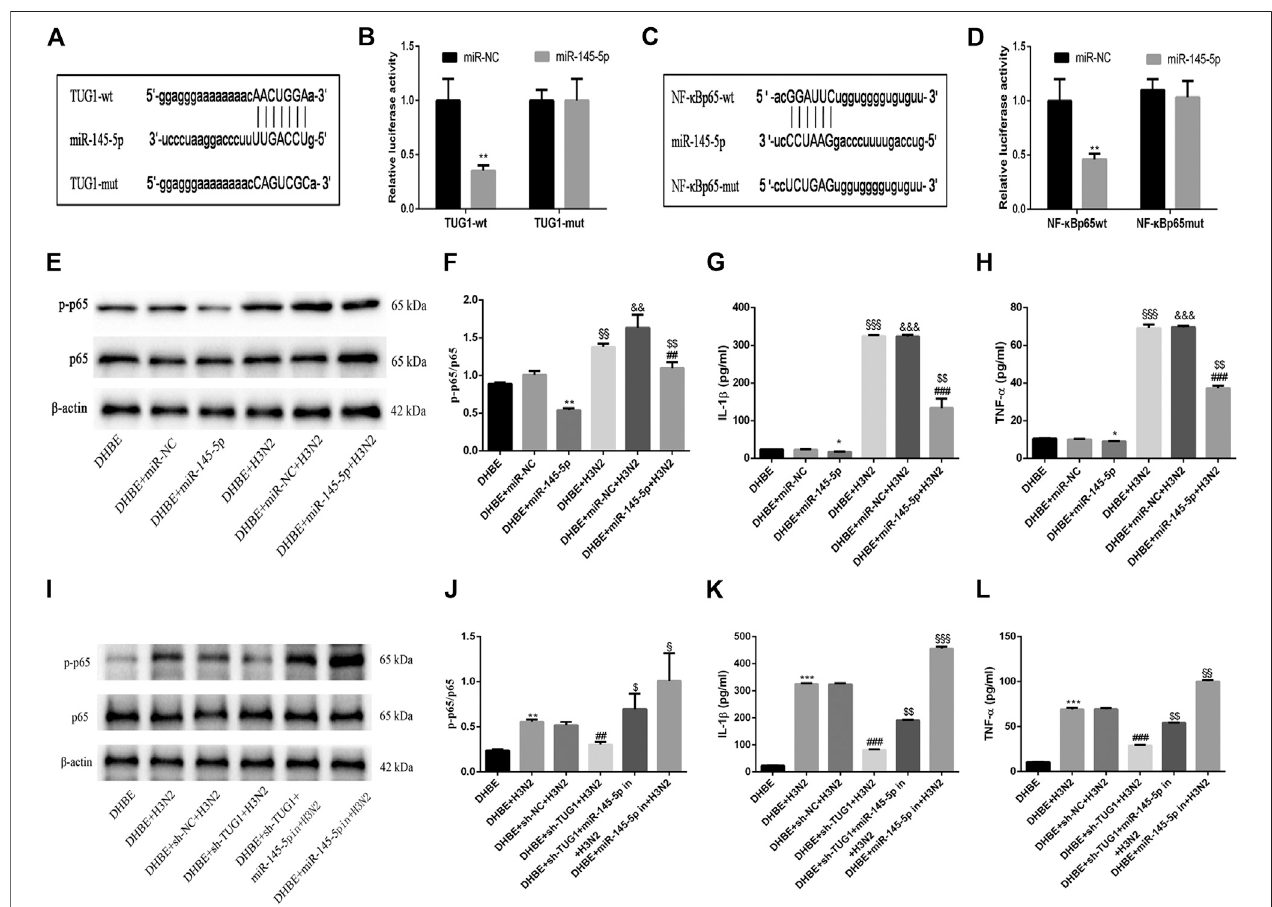
FIGURE 4 | lncRNA TUG1 positively regulated the IAV induced airway in fl ammation by sponging miR-145-5p in DHBE. (A) The putative miR-145-5p binding sequence of TUG1 mRNA. (B) Luciferase activity was measured between miR-145-5p (wt and mut) and TUG1 (wt and mut). (C) The putative miR-145-5p binding sequence of the 3 ′ UTR of NF- κ Bp65. (D) Luciferase activity was measured between miR-145-5p (wt and mut) and NF- κ Bp65 (wt and mut). (E,F) The protein expressions of NF - κ Bp65 and phospho-NF - κ Bp65 were analyzed in DHBE pretreated with or without miR-145-5p mimic by Western blotting. (G,H) The protein expressions of proin fl ammatory cytokines IL-1 β and TNF- α were analyzed in DHBE pretreated with or without miR-145-5p mimic by ELISA (* p ＜ 0.05, ** p ＜ 0.01 as comparedtoDHBE+miR-NCgroup, ## p ＜ 0.01, ### p ＜ 0.001ascomparedtoDHBE+H3N2group, §§ p ＜ 0.01, §§§ p ＜ 0.001ascomparedtoDHBEgroup, && p ＜ 0.01, &&& p ＜ 0.001 as compared to DHBE+ miR-NC group, $$ p ＜ 0.01 as compared to DHBE+ miR-NC +H3N2 group). Each dataset comprises three independent experiments. (I,J) The protein expressions of NF - κ Bp65 and phospho-NF - κ Bp65 were analyzed in DHBE pretreated with or without sh-TUG1/miR-145-5p inhibitor by Westernblotting. (K,L) Theprotein expressions ofproin fl ammatory cytokines IL-1 β and TNF- α wereanalyzed inDHBEpretreated withorwithoutsh-TUG1/miR-145-5p inhibitorbyELISA( ** p ＜ 0.01, *** p ＜ 0.001ascomparedtoDHBEgroup, ## p ＜ 0.01, ### p ＜ 0.001ascomparedtoDHBE+sh-NC+H3N2group, $ p ＜ 0.05, $$ p ＜ 0.01as compared to DHBE+ sh-TUG1+H3N2 group, § p ＜ 0.05, §§ p ＜ 0.01, §§§ p ＜ 0.001 as compared to DHBE+ sh-TUG1+miR-145-5p in+H3N2 group). Each dataset comprises three independent experiments.